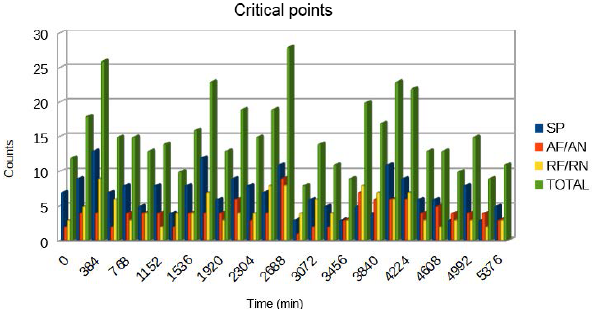
Figure 5. Noncumulative counts of critical points detected on the 2-D LCT flows obtained from the evolution of the magnetic field around the PIL for the period of 3.6d. The colors show their clas- sification: blue is saddle point (SP), red is attracting node or focus (AN/AF), and yellow is repelling node or focus